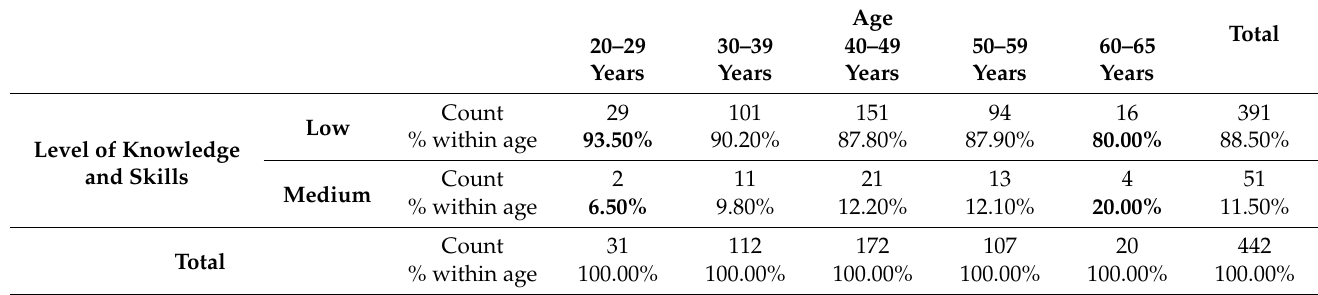
Table 6. Level of knowledge and aptitude according to age.